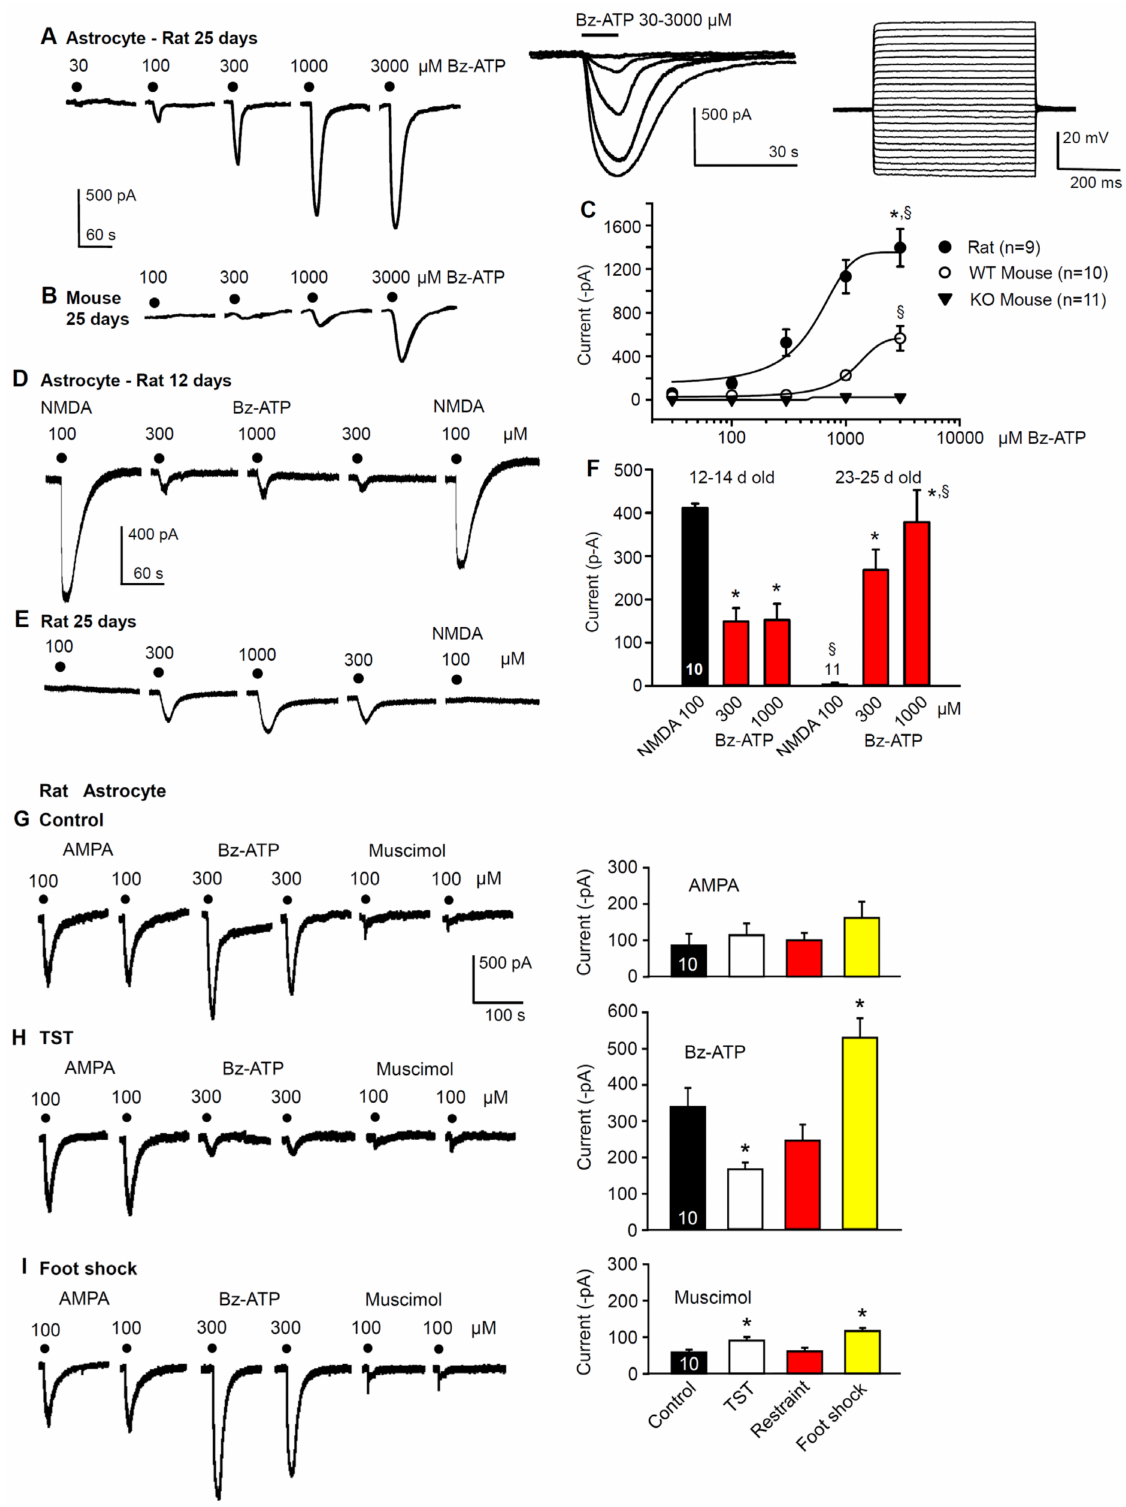
Figure 3. Bz-ATP-induced current responses in the hippocampal CA1 astrocytes of rats and mice, and their modification after the development of learned helplessness. Concentration-dependent increase of the current amplitudes ( A ) and current durations ( A , left inset ) caused by Bz-ATP, in preparations taken from 25-day old rats; representative tracings recorded at a holding potential of − 80 mV.